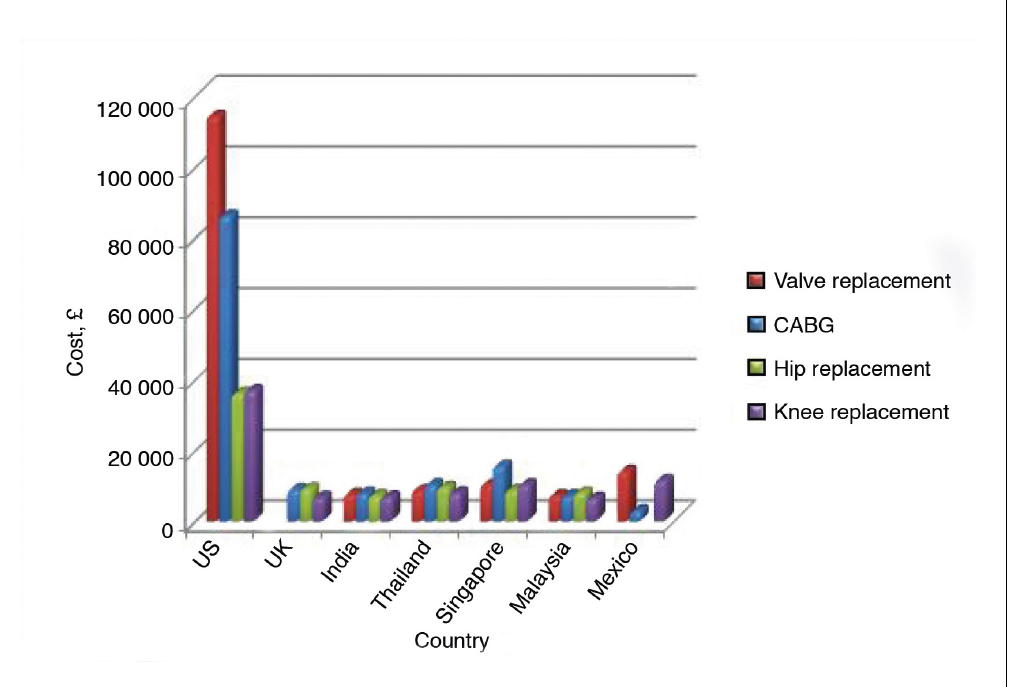
Figure 1. Comparative costs of medical procedures in different countries in US$. 4 CABG = coronary artery bypass